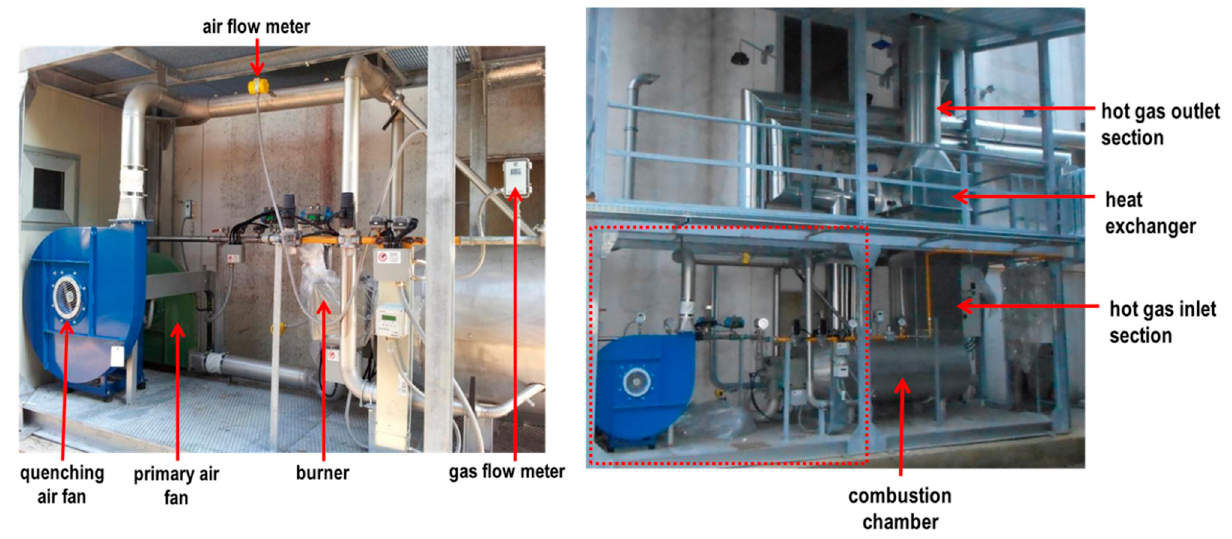
Figure 4. Front view picture and details of the MSH mock-up. A differential pressure gauge was also installed on the system in order to monitor the pressure in the combustion chamber and pressure